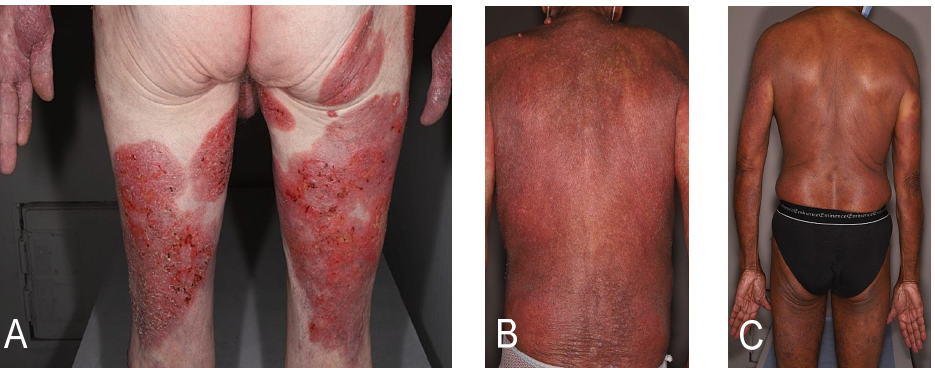
Figure 1. Clinical presentations of advanced-stage disease. ( A ) Mycosis fungoides with tumors (stage IIB); ( B ) mycosis fungoides with erythroderma (stage III); ( C ) S é zary syndrome with significant blood involvement (stage IV).